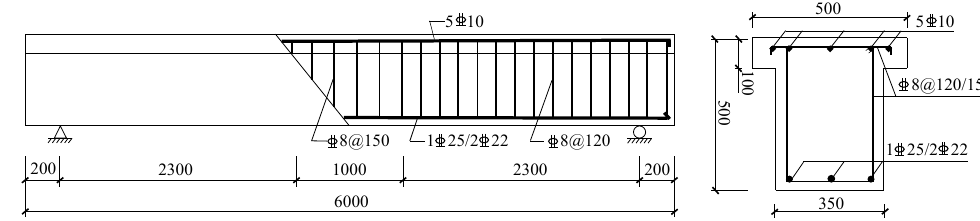
Figure 1. Schematic of an RC beam (unit in mm).